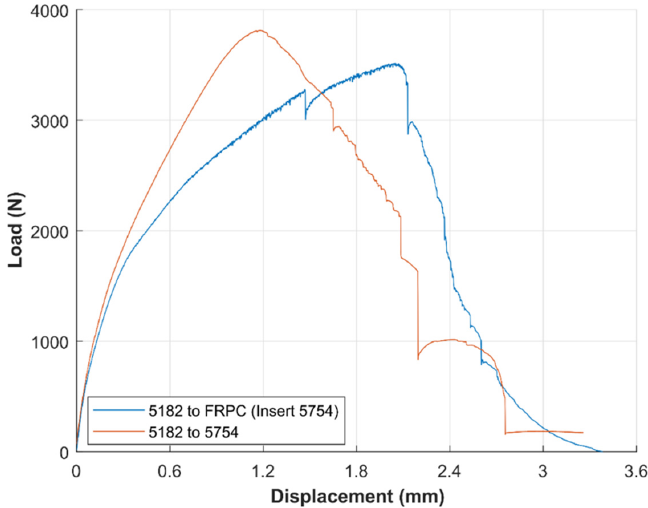
Figure 14. Quasi-static lap shear typical curves comparison between joints of 5182/FRPC (insert 5754) and MPS welded 5182/5754 joints under the same conditions.